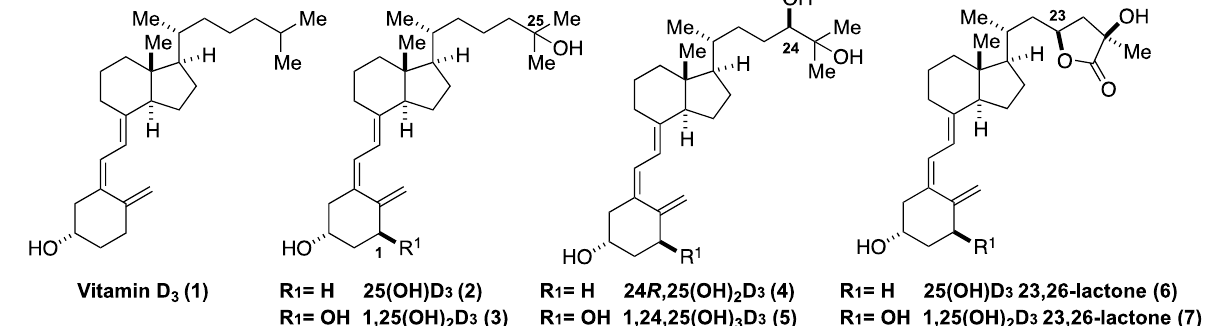
Figure 1. Structures of vitamin D 3 ( 1 ) and its metabolites ( 2) –( 7 ).